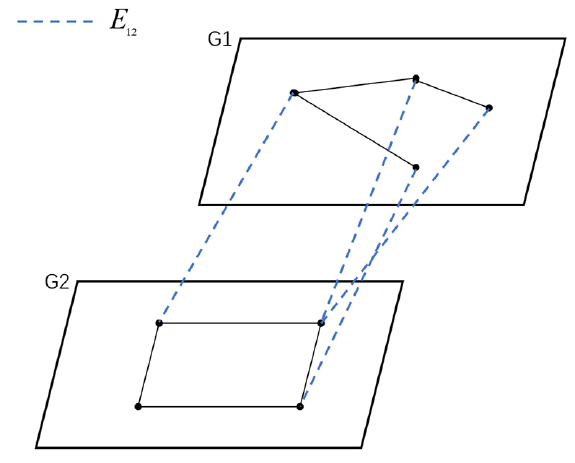
Figure 6. Interdependent network model.